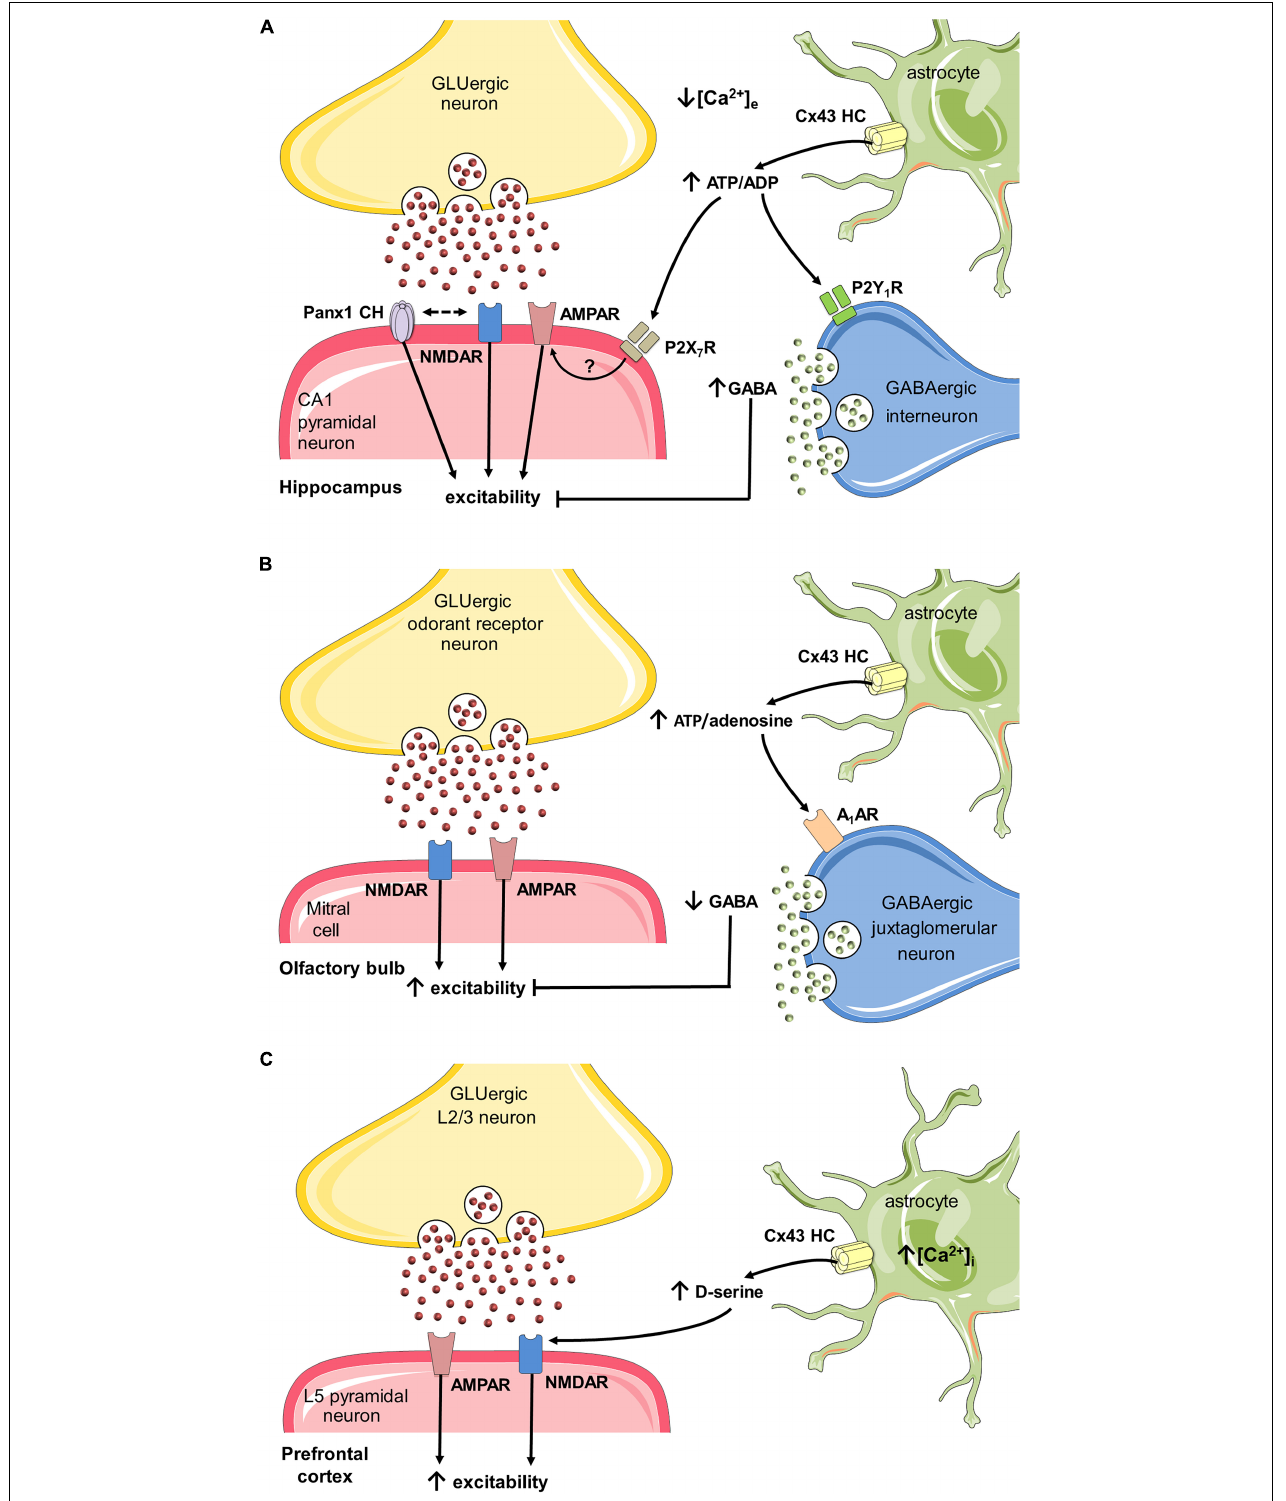
FIGURE 3 | Possible roles of hemichannels and pannexons in synaptic plasticity through activation of astrocytes. (A) During basal glutamatergic signaling in the hippocampus, Ca 2 + influx into neurons leads to a localized reduction in [Ca 2 + ] e , which in turn opens Cx43 hemichannels (HCs) on astrocytes (Torres et al., 2012), resulting in the release of ATP. In the synaptic cleft, this gliotransmitter sustains basal excitatory synaptic transmission (Chever et al.,